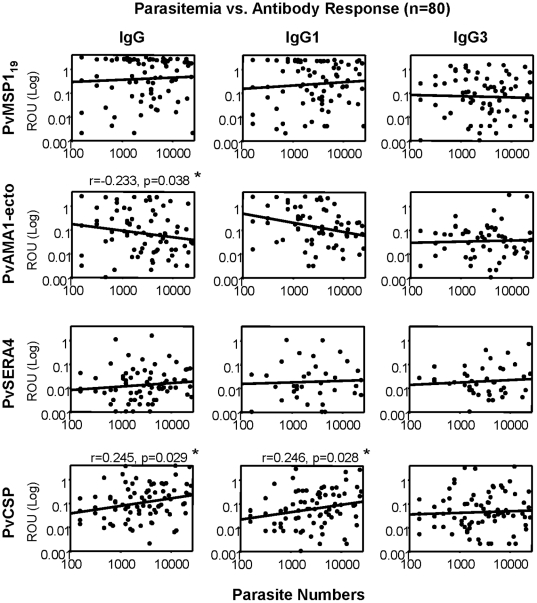
Correlation between parasite density and antibody levels.Total IgG, IgG1 and IgG3 antibody responses (ROU) to P .vivax MSP119, PvAMA1-ecto, PvSERA4 and chimeric PvCSP antigens were measured in individuals with patent P vivax infection (n = 80). Correlations were evaluated using Spearman's correlation test. Significantly correlated values are marked on each figure (*).